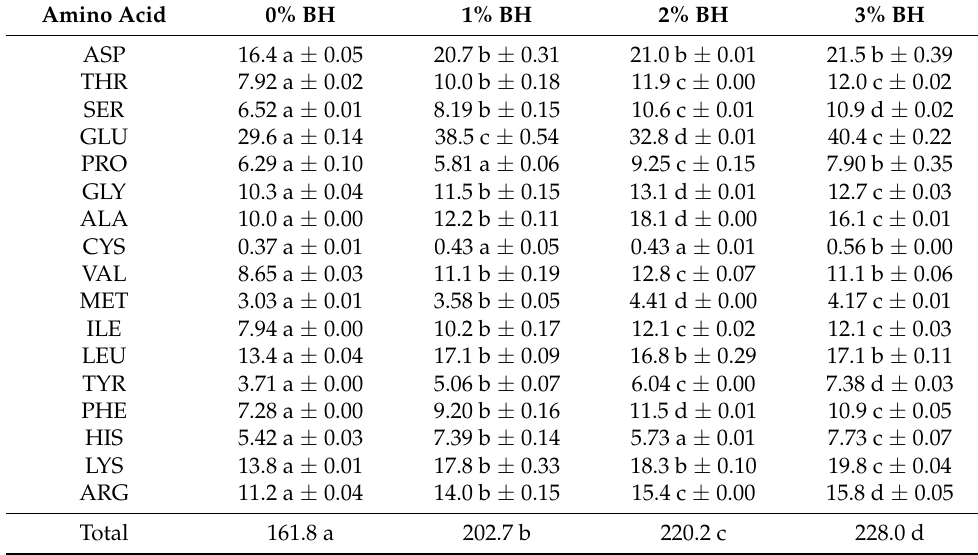
Figure 1. Results of organoleptic evaluation. Table 5. Effect of BH on amino acid content in sausages